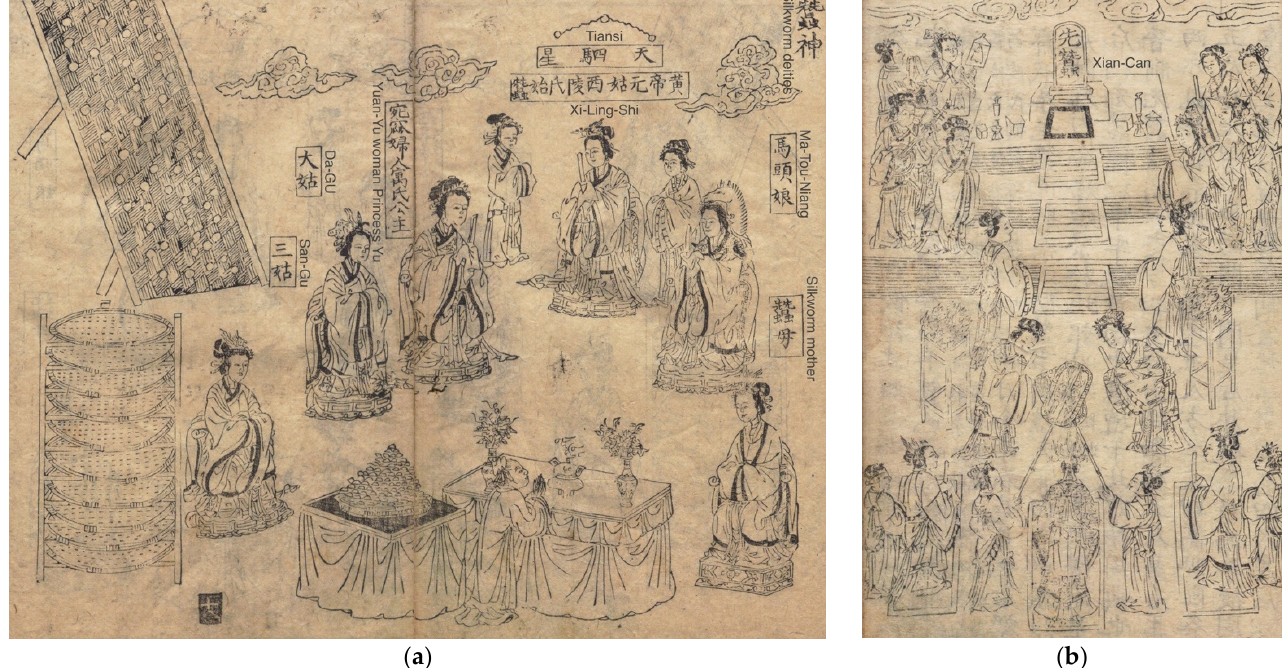
Figure 3. ( a ) “ Silkworm deity ”. Photo Source: Nong Shu 农书 (1304). ( b ) “Can Tan 蚕坛 ”. Photo Figure 3. ( a ) “Silkworm deity”. Photo Source: Nong Shu 农 书 (1304). ( b ) “Can Tan 蚕 坛 ”. Photo Source: Nong Shu 农书 (1304). Source: Nong Shu 农 书